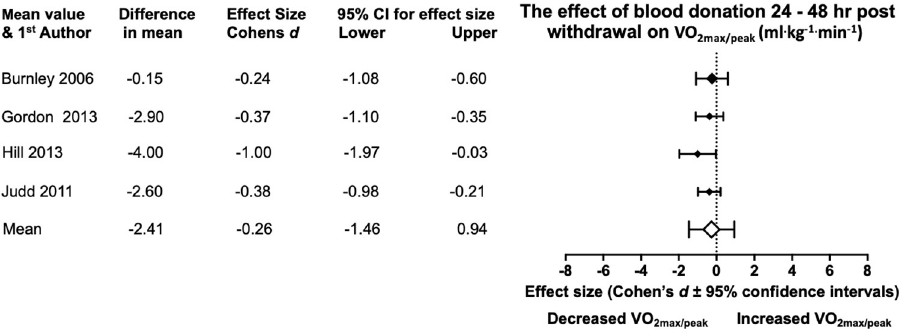
With the diamonds reflecting 2 max = peak